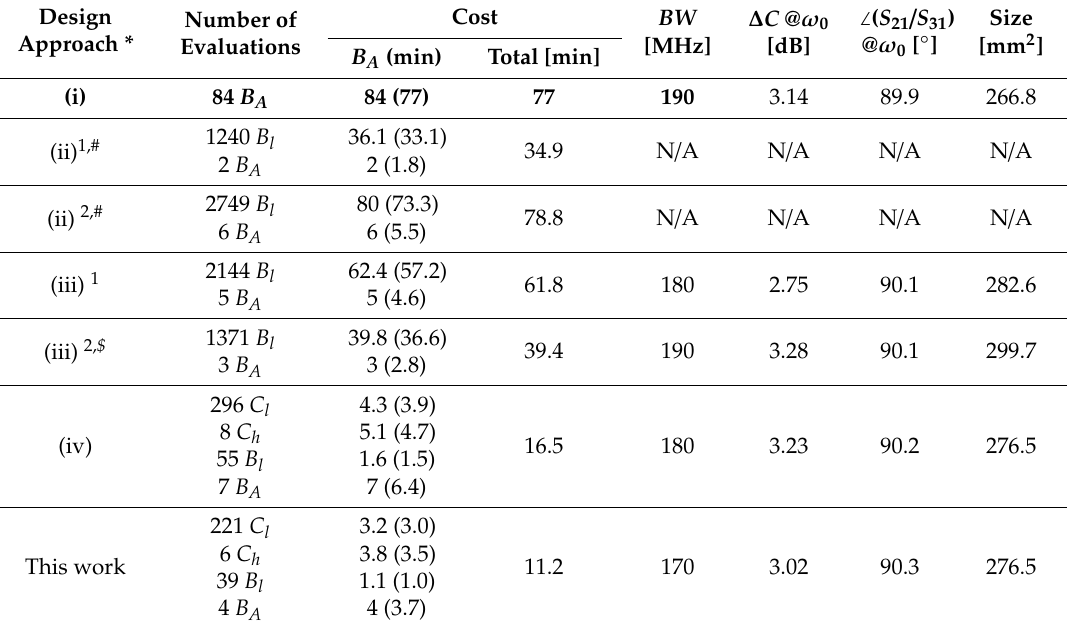
Table 1. Surrogate-Assisted BLC Design: Benchmark